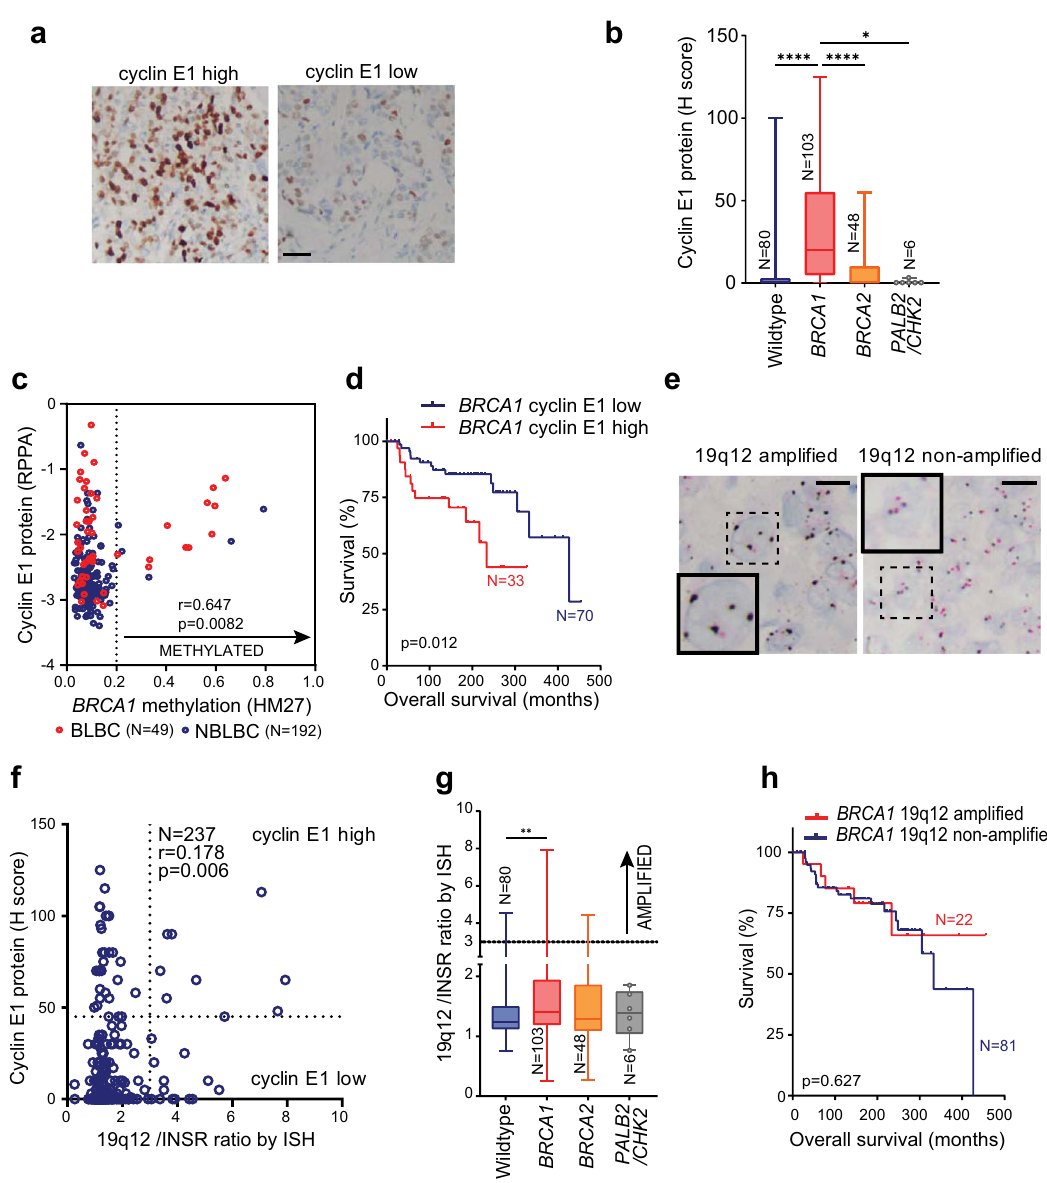
Fig. 1 Cyclin E1 is elevated in BRCA1 de fi cient cancers, and predicts poor prognosis. a Microscope images of high and low expression of cyclin E1 (IHC). Scale bar is 50 µm. b Cyclin E1 protein expression (H score) in wildtype, BRCA1 , BRCA2, and PALB2 / CHEK2 mutated cancers, analysis by one-way ANOVA; * p < 0.05; **** p < 0.0001. Box and whisker plots show error bars of minimum to maximum, where the box extends from the 25th to the 75th percentile, and the line in the middle of the box indicates the median. c Scatter plot of TCGA breast cancer cohort cyclin E1 protein expression (RPPA) versus BRCA1 methylation by HM27 array. Dashed line indicates cut-off between methylated and non- methylated. Correlation analysis of cyclin E1 protein and BRCA1 methylation performed across the methylated subset, r = Spearman coef fi cient. d Kaplan – Meier curves of overall survival in the KConfab cohort comparing BRCA1 mutated cyclin E1 high cases versus BRCA1 mutated cyclin E1 low cases. e Microscope images of 19q12 non-ampli fi ed and 19q12 ampli fi ed breast cancer cases (ISH); inset shows representative example of each. Scale bar is 20 µm. f Scatter plot of cyclin E1 protein expression versus CCNE1 (19q12/INSR ratio) ampli fi cation status in the KConfab cohort. r = Spearman coef fi cient. g 19q12/INSR ratio (ISH) cases compared to each of wild type, BRCA1 , BRCA2, PALB2 / CHK2 mutated cancers in the KConfab Cohort, analyzed by one-way ANOVA; ** p < 0.01. Box and whisker plots show error bars of minimum to maximum, where the box extends from the 25th to the 75th percentile, and the line in the middle of the box indicates the